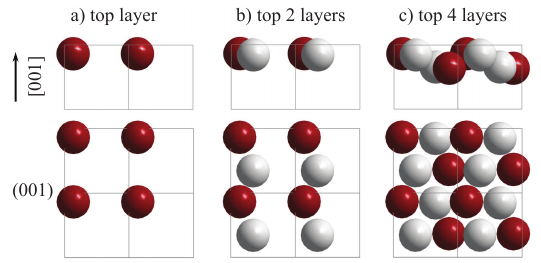
Figure 12. The FeSi(001) surface. The evolution of the surface structure and symmetry is shown by increasing the number of layers in ( a – c ). The upper row shows the side view and the lower row the top view. Fe atoms are drawn in red ( dark ) and Si atoms in grey ( light